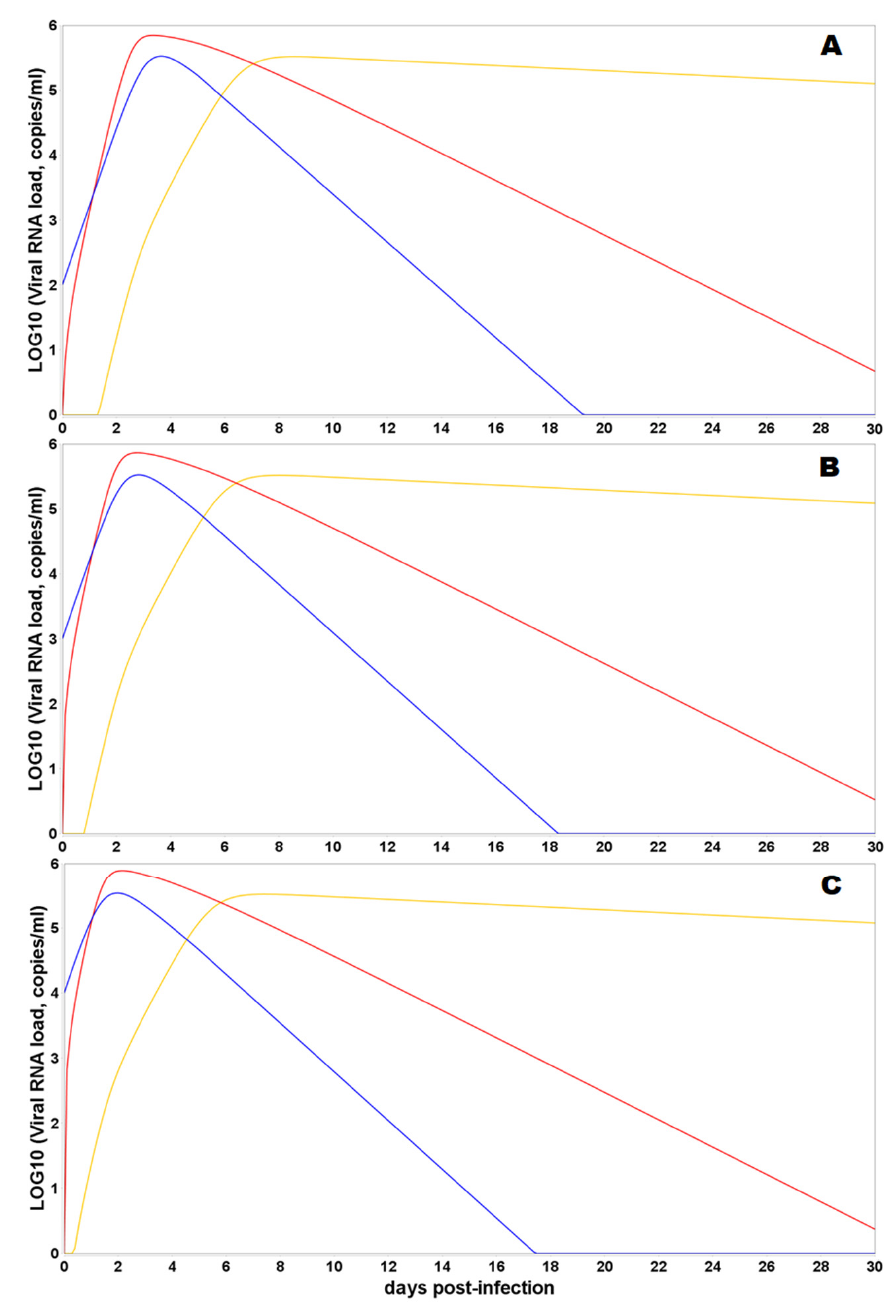
Figure 5. Predicted viral load trajectories in the nasopharyngeal region (NP, blue curve), gastroin- testinal tract (Intestine, red curve), and lungs (Lung, orange curve) are shown. The time of humoral immune response initiation in each compartment is the same as in Figure 4. The initial viral load is varied in the NP. Y -axis—log10 of viral load (copies/mL); X -axis—days from the moment of infection. ( A ) Initial dose of the viral particles corresponds to 10 2 , ( B ) initial dose is 10 3 , and ( C ) initial dose is 10 4 .